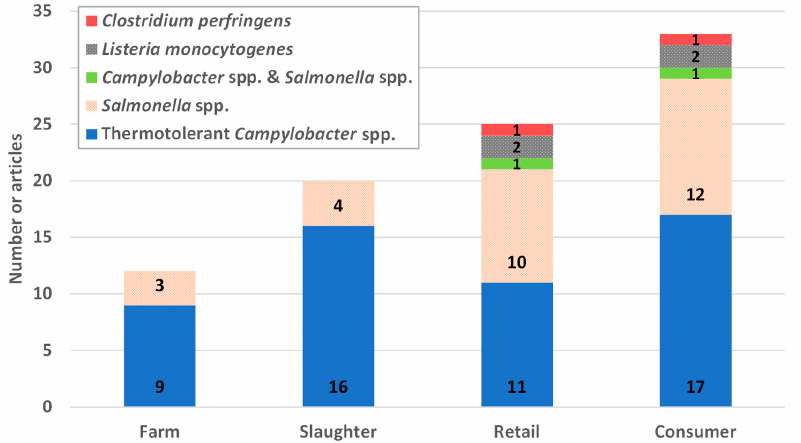
Figure 4. Frequency of farm-to-fork chain steps studied in the QMRA studies.